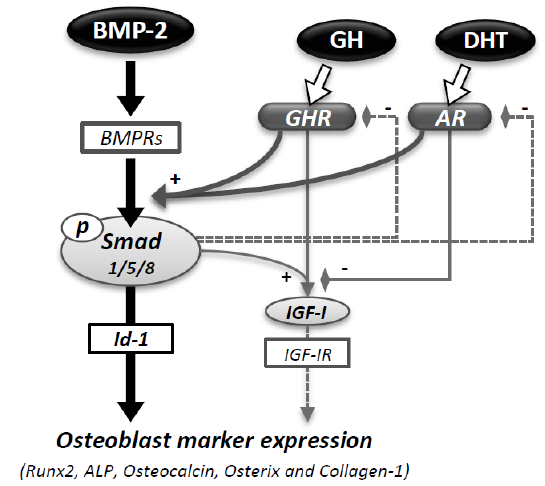
Figure 6. Interaction of androgen and GH in BMP-induced osteoblast marker expression. Combined treatment with DHT and GH enhanced BMP-2-induced expression of osteoblast markers. DHT and GH augmented BMP-2-induced Smad1/5/8 signaling and Id-1 transcription in C2C12 cells. The IGF-I mRNA level was amplified by GH and BMP-2, and the effect was reversed by DHT. The expression of AR and GHR was suppressed by BMP-2, suggesting a possible feedback loop.